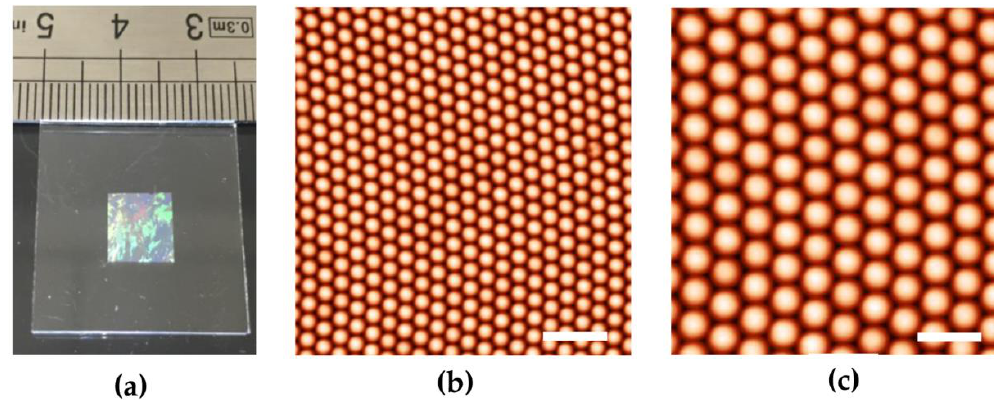
Figure 3. ( a ) Photograph of the CPA self-assembled monolayer after the transfer onto a glass substrate. AFM images at low ( b ) and high ( c ) magnifications of a CPA of polystyrene (PS) particles with a diameter of 500 nm. The scale bars are 2 and 1 µ m,